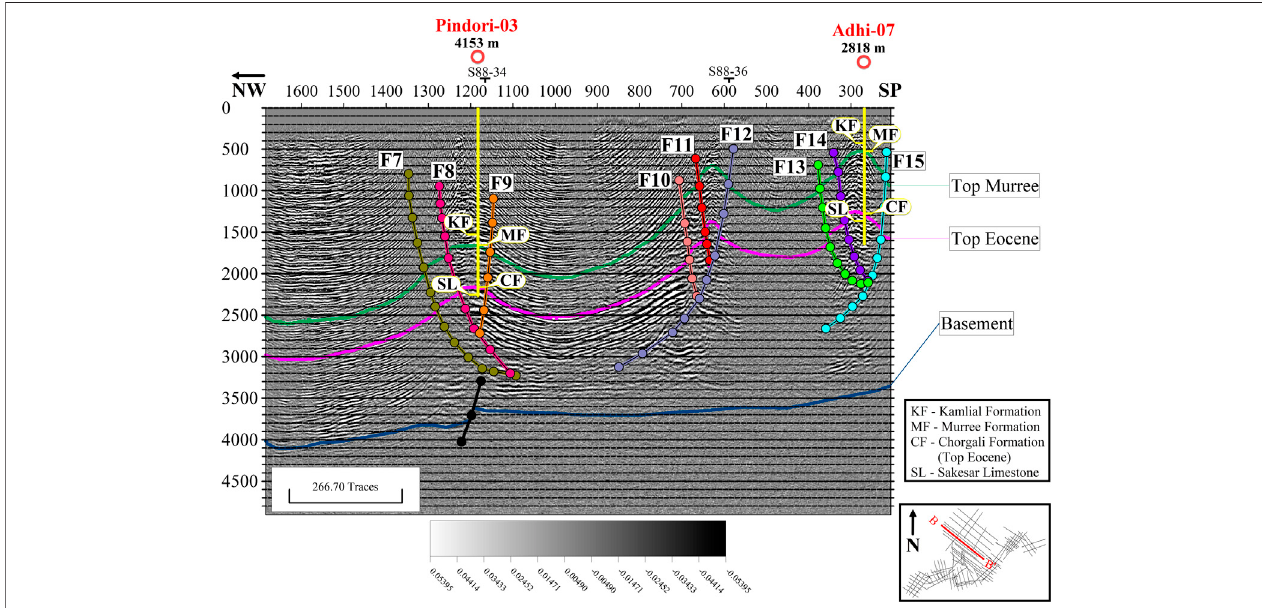
FIGURE 6 | Interpreted seismic section of line SOX-S88-08 (zone-2) showing salt-cored anticlinal structures of Pindori (left), Bhangali (middle), and Adhi (right) fi elds. Murree Formation lies at a greater depth in Pindori-03 well whereas it is encountered at a very shallower depth in Adhi-07 well.